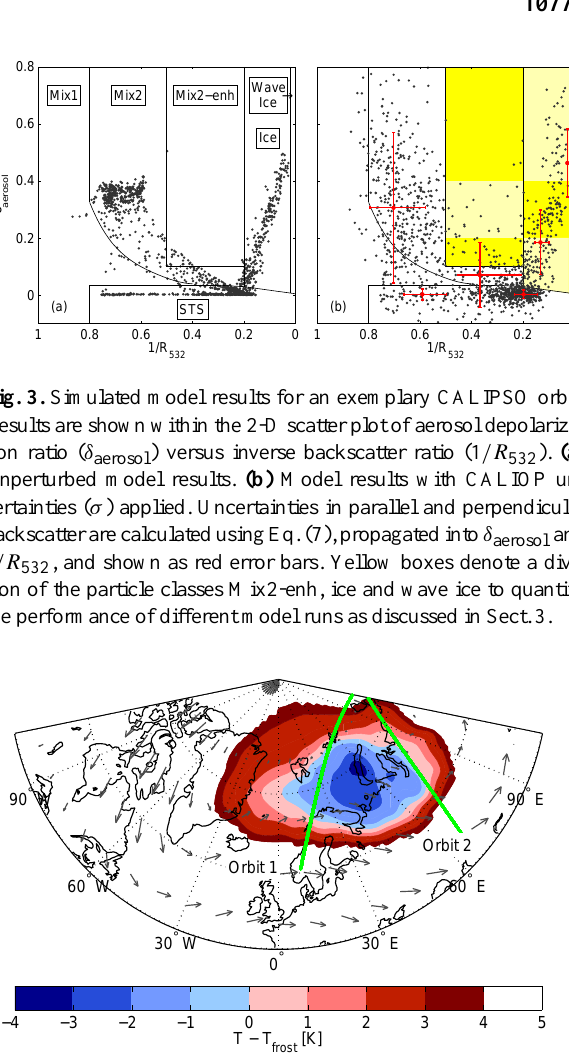
Fig. 4. Geographical location of two selected CALIPSO orbit tracks on 18 January 2010. Referring to the Supplement of Pitts et al. (2011), Orbit 1 is defined as 2010-01-18T01-58-53Z and Orbit2 as 2010-01-18T21-45-30Z. ERA-Interim wind fields (arrows) and temperatures (color-coded relative to T frost ) are shown at the 30hPa pressure level for